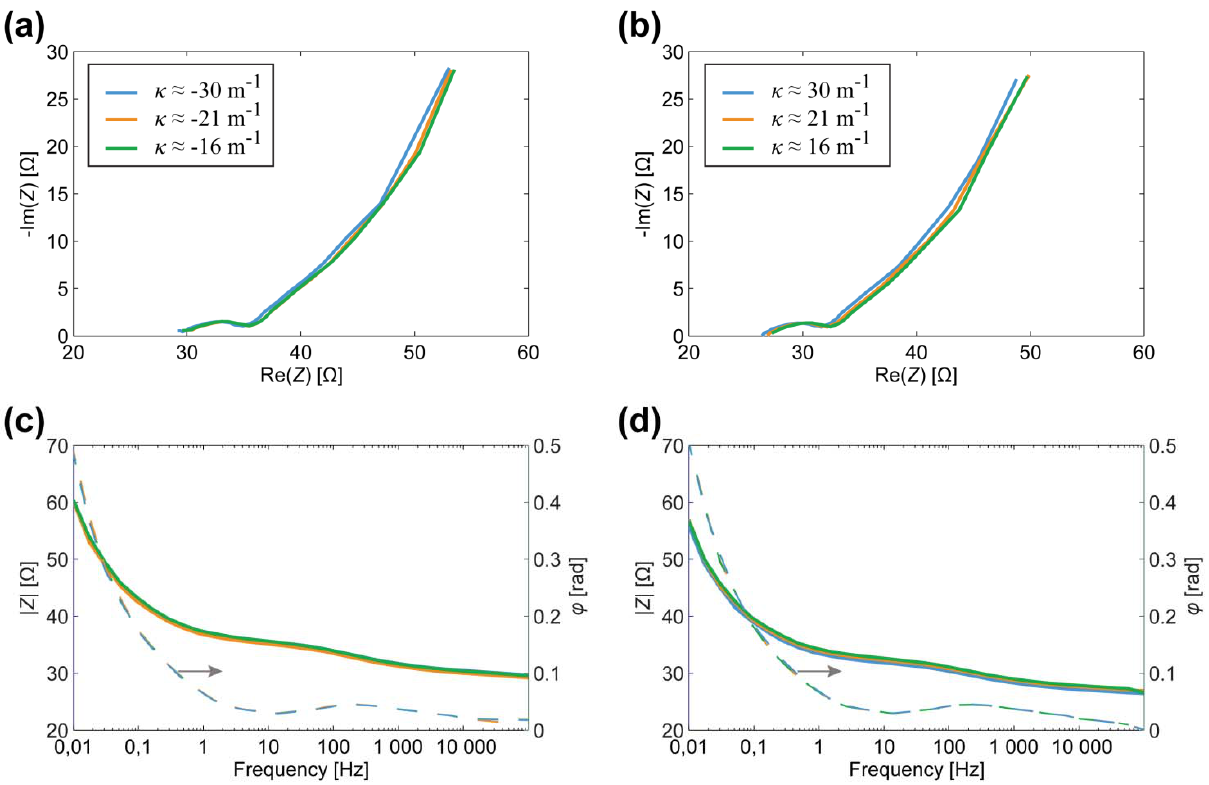
Figure 6. The correlation between the cross-electrode impedance and the curvature of a CPC actuator. ( a ) Nyquist plot for bending in one direction; ( b ) Nyquist plot for bending in another direction; ( c ) Bode plot for bending in one direction; ( d ) Bode plot for bending in another